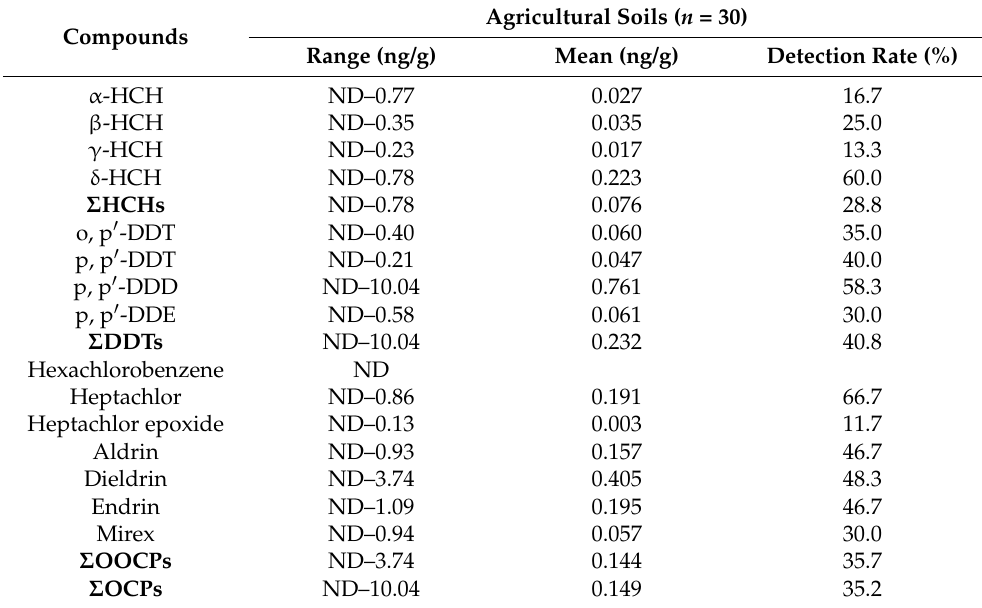
Table 1. Concentrations of OCPs in agricultural soils collected from Xiamen.